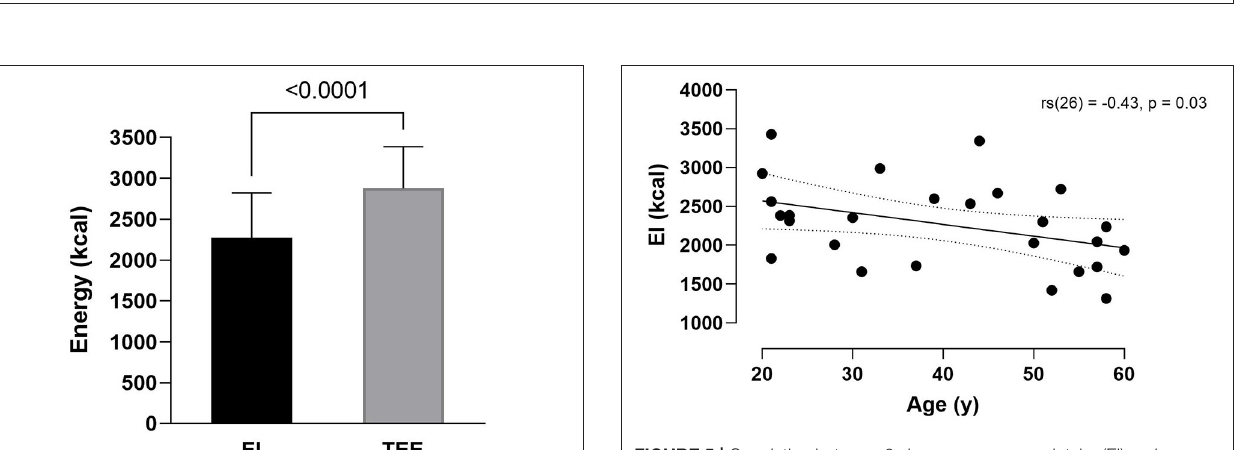
FIGURE 5 | Correlation between 3-day average energy intake (EI) and age. Dotted lines denote 95%